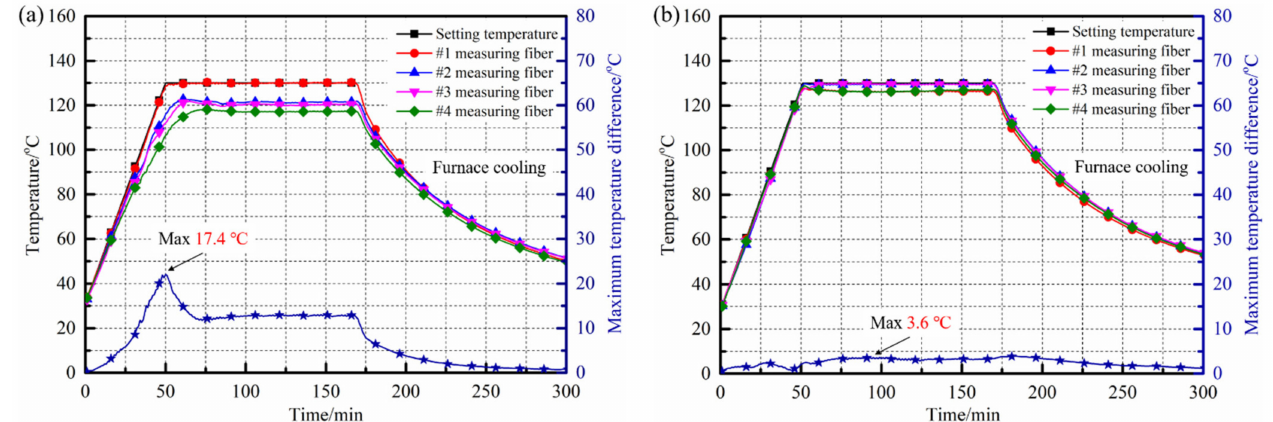
Figure 16. Internal temperature distribution of composite laminates during microwave curing of different devices: ( a ) traditional heating device; ( b ) regulating